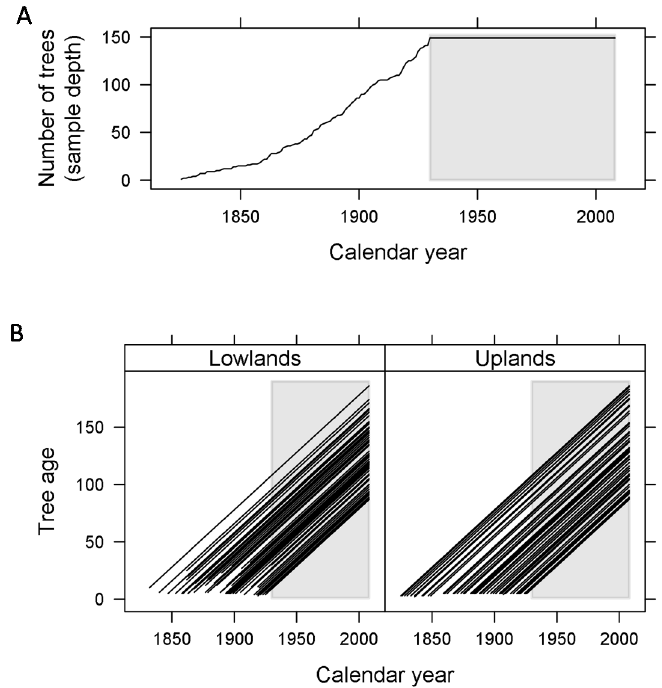
Figure 2. ( A ), number of trees over time (sample depth). ( B ), age over time of the 149 beech trees (84 in lowlands, 65 in uplands). The grey rectangles indicate the period 1930–2008, common to all the trees (i.e., with constant sample depth). Tree age was estimated as the number of rings from pith to bark plus 5 (i.e., the number of years to reach the breast height). In the case of cores with missing pith